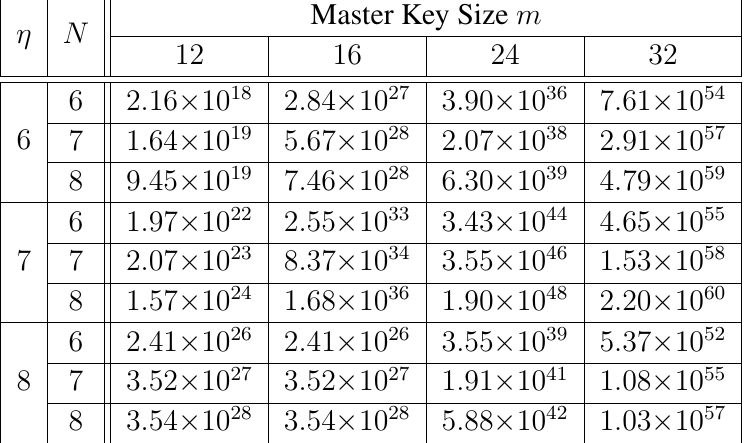
Table 2. Number of Solutions Φ